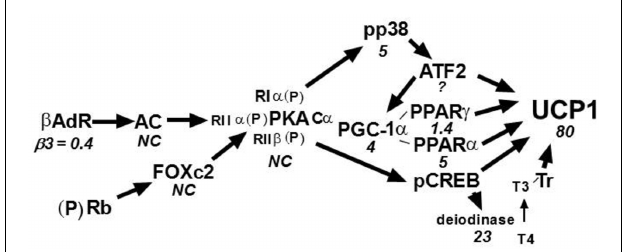
FIGURE 7 | Signaling and transcription components of Ucp 1 regulation. The number below each regulatory factor refers to the ratio of expression in A/J vs. B6 mice. Except for the β 3-adrenergic receptor, expression is higher in B6 than A/J at either the mRNA or protein levels; however, these strain-dependent differences all occur downstream of PKA. Most important is that none of the strain-dependent differences for the regulatory factors approaches the difference observed for Ucp 1 at either the mRNA or protein levels.This suggests that synergy among the regulatory pathways occurs with a changing cast of factors depending on the genotypes of Iba genes and environmental conditions. NC = No difference in expression between A/J and